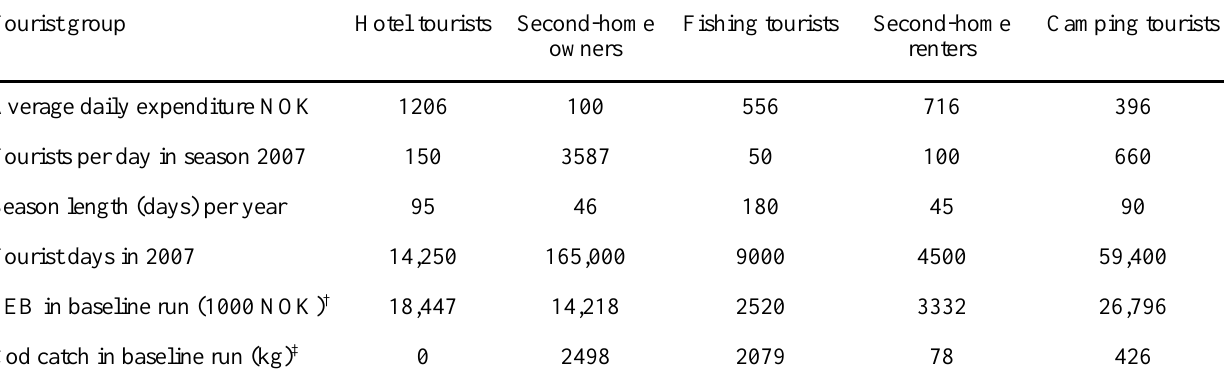
Table 2. Data by tourist group used in the economical component of the model (NOK = Norwegian kroner; 1 € is approximately 8 NOK; LEB = local economic